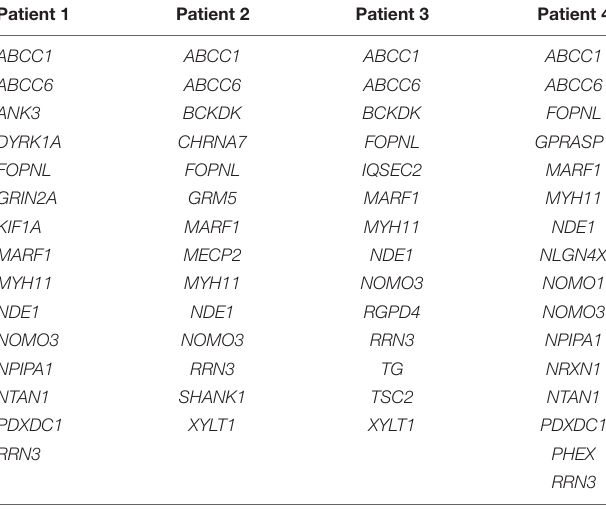
TABLE 1 | Gene signatures for the four patients. a